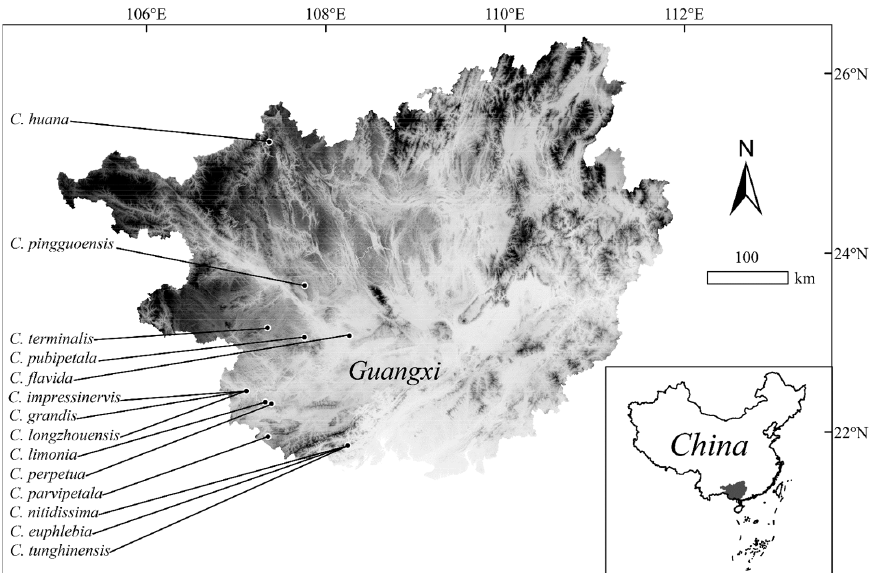
Figure 1. Collection sites of 14 species of golden Camellia . The map was downloaded from Geospatial Data Cloud (https://www.gscloud.cn, accessed date: 12 October 2021).